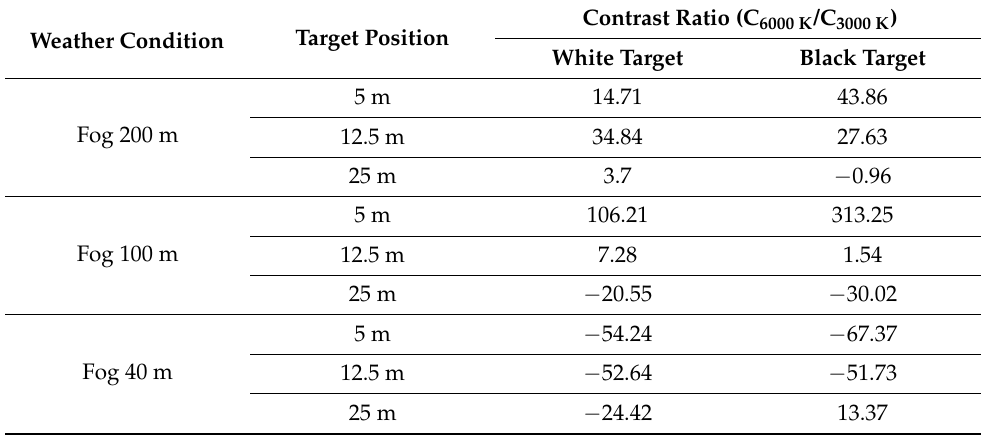
Table 10. 3000 K contrast ratio compared to 6000 K in fog